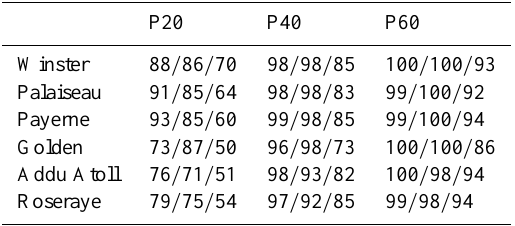
Table 5. Percentage of data falling within ± 20, ± 40 and ± 60Wm − 2 in SPN1 – TBM measurement differences (three val- ues at each cell, corresponding to GHI, DHI and DNI irradiances respectively). SPN1 values have been recalibrated as described in Sect.